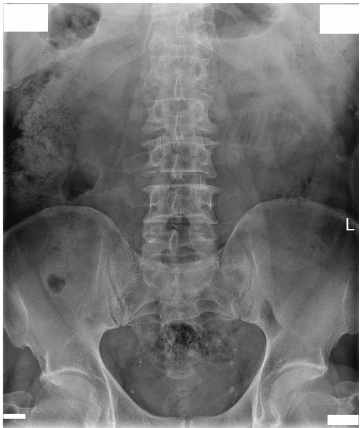
Figure 7: Plain X-ray image shows complete removal of the nitinol mesh stent and incrustations after percutaneous nephrolithotomy.